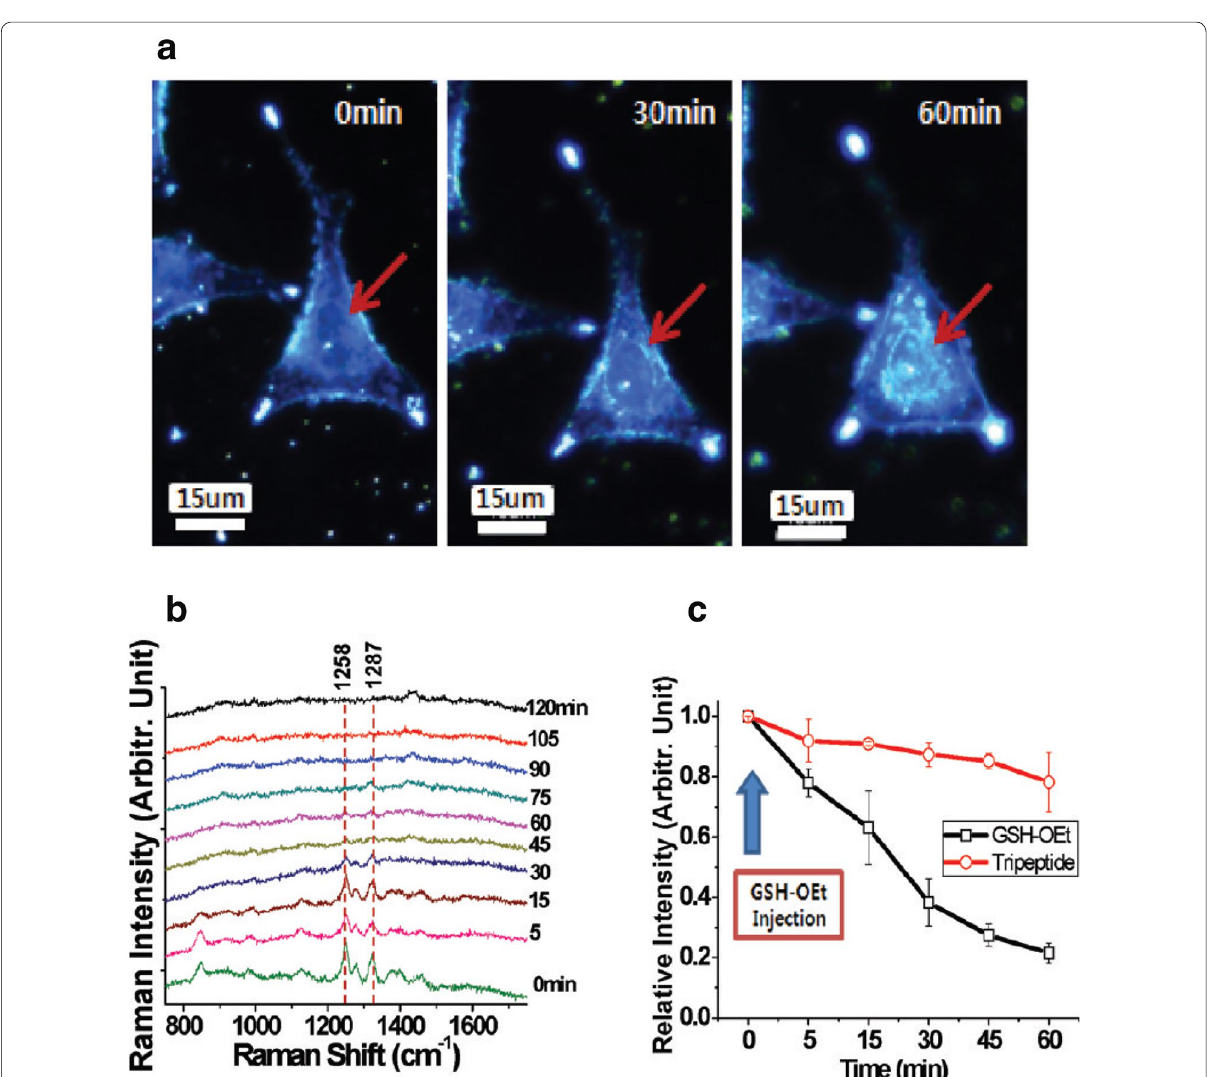
Fig. 10 a Time‑lapse DFM live cell images in a single A549 cell after treatment of glutathione ethyl ester (GSH‑OEt) indicating the in situ release of 6MP from Au NPs. The arrow indicates the position where the Raman spectra were obtained. The Au NPs were incubated for 24 h prior to the GSH‑OEt treatment. b The peak at 1258 cm − 1 was monitored with time. The other vibrational bands of 6MP also showed similar behaviors. Raman spectra were obtained after a few minutes from the injection time of GSH‑OEt. c Plot of decrease in the band intensities depending on the elapsed time after GSH‑OEt injection. The error bar indicated the standard deviation of the three measurements. GSH‑OEt and tripeptides were marked in black and red, respectively (Reprinted with permission from [101]. Copyright @ 2002 American Chemical